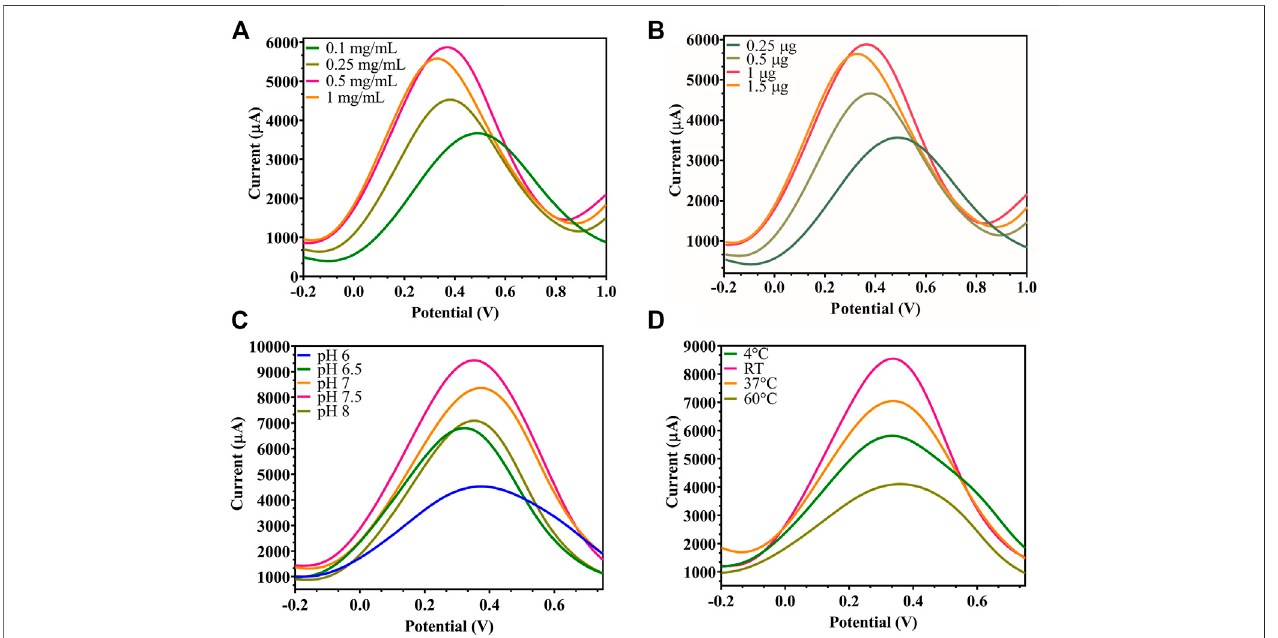
FIGURE 4 | Modi fi ed FTO electrode optimization: (A) DPV of rGO-immobilized FTO sensor, where the rGO concentration was decreased from 1, 0.5, 0.25 to 0.1 mg/ml, showed maximum signal at 0.5 mg/ml; (B) DPV of Ab-immobilized FTO/rGO electrode where BACE1 Ab concentration was decreased from 1.5, 1, 0.5 to 0.25 µg,showedoptimumsignalat1 μ g; (C) DPVofFTO/rGO/BACE1AbelectrodewherepHwasincreasedfrom6,6.5,7,7.5to8,andpH7.5gavemaximum current output; (D) DPV of FTO/rGO/BACE1Ab electrode where temperature was increased from 4 ° C, RT, 37 ° C to 45 ° C, and room temperature showed the highest current